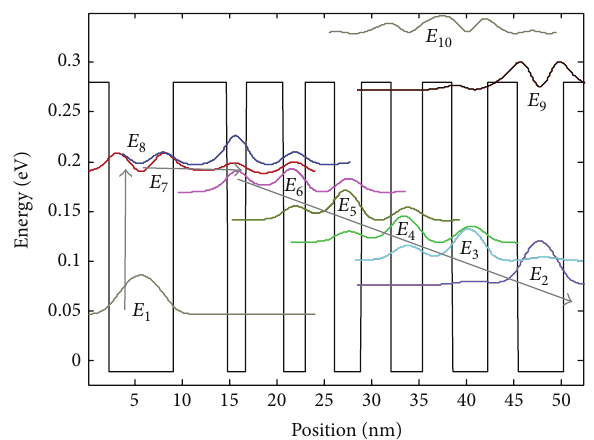
Figure1:Self-consistedcalculatedconductionbandstructureofone